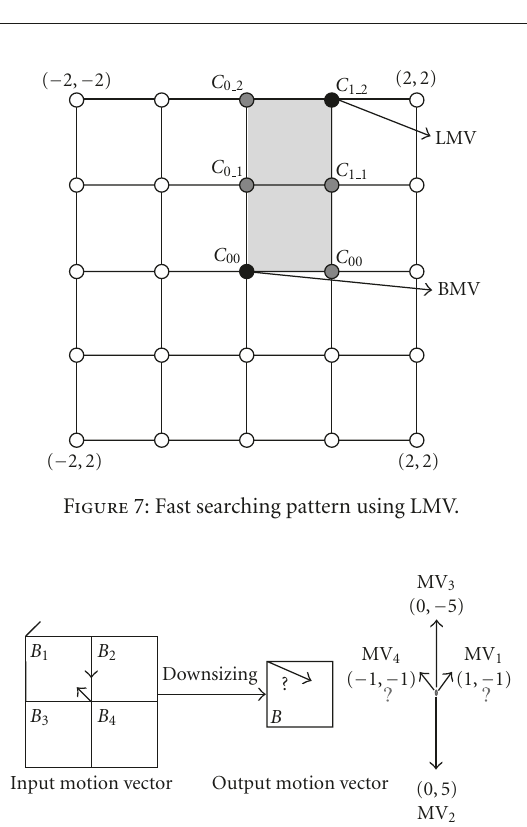
Figure 8: Example of the di ff erent direction motion vectors having the same